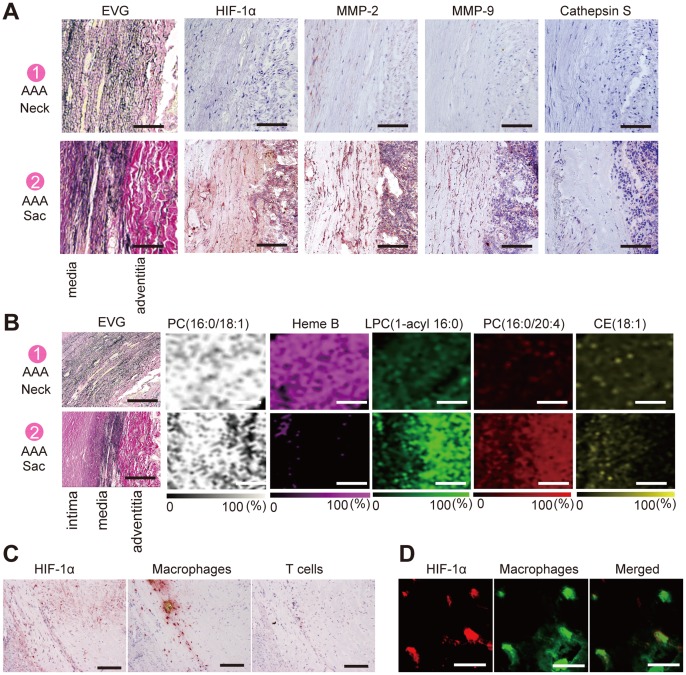
Distribution of lipid molecules and HemeB.(A) Elastica Van Gieson (EVG) staining and immunostaining of HIF-1α, MMP-2, MMP-9, and Cathepsin S in the aortic wall. Comparison of the distribution of these molecules in the aortic wall between the neck and sac regions. Brown color indicates the positive signals in all immunostaining pictures. Scale bar = 50 µm (from left to right). (B) Comparison of the distribution of Heme B, phosphatidylcholine (PC) (16∶0/18∶1), lyso-PC (LPC) (1-acyl 16∶0), PC(16∶0/20∶4), and cholesteryl ester (CE) (18∶1), in the aortic wall between the neck and sac regions, as analyzed by matrix-assisted laser desorption/ionization imaging mass spectrometry (MALDI-IMS). Scale bar = 100 μm. (C) HIF-1α, macrophages, and T cells in the AAA sac. Scale bar = 200 µm. (D) Immunofluorescence analysis of HIF-1α and macrophages in the AAA sac. Scale bar = 5 µm.